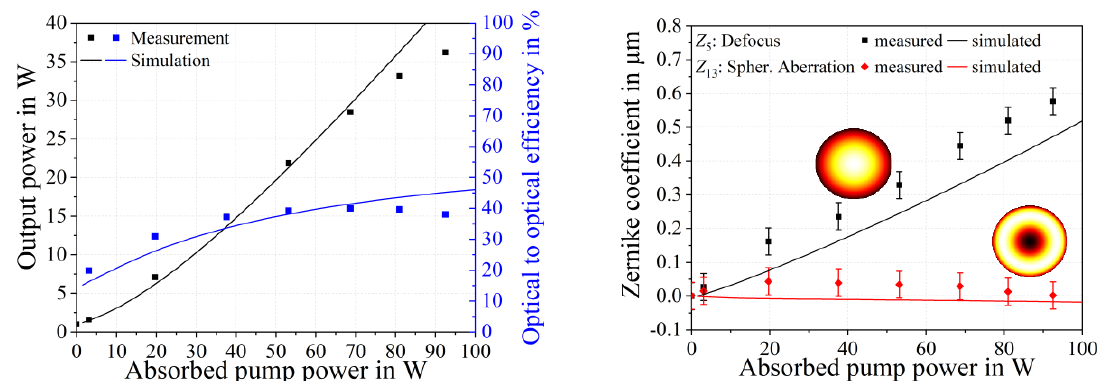
Fig. 1, left: power slope and optical-to-optical efficiency, right: symmetrical Zernike coefficients versus absorbed pump